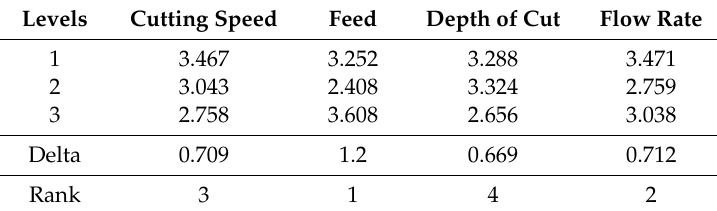
Table 6. Response table for surface roughness.